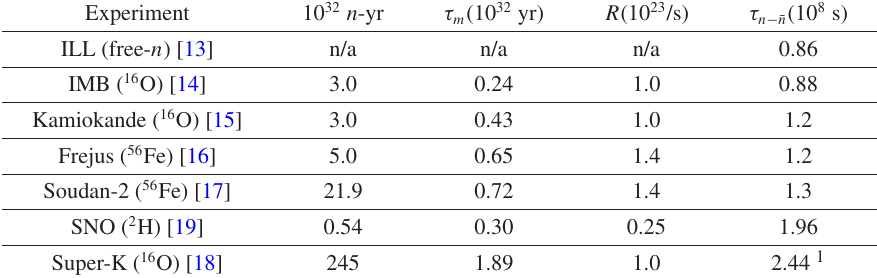
Table 1. Neutron-antineutron lifetime lower limits (90% CL).